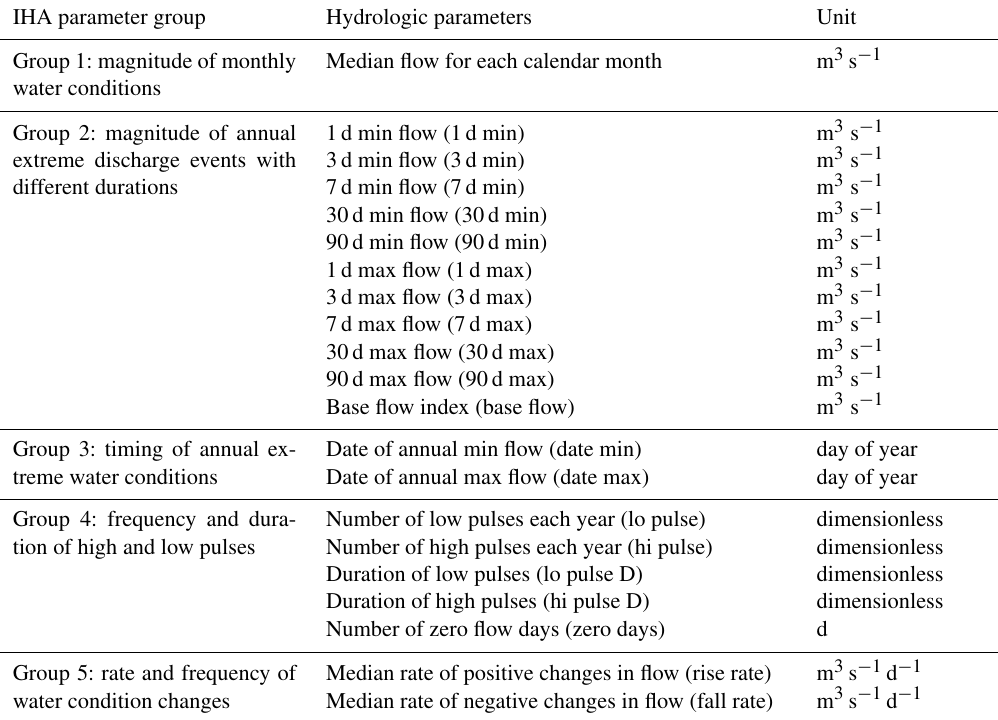
Table 6. The set of 32 Indicators of Hydrologic Alteration categorized into five groups (Richter et al., 1997). IHA parameter group